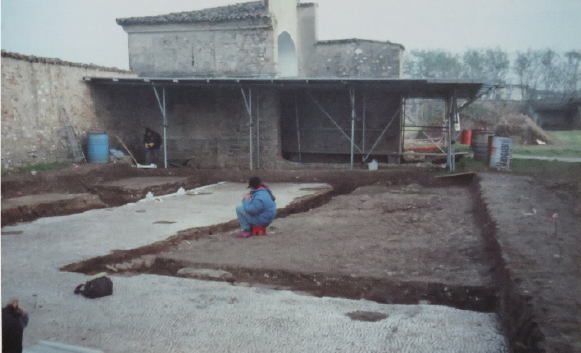
Figure 1: Image of the area during the archaeological excavation of 1995 (source: Menotti, 2002).